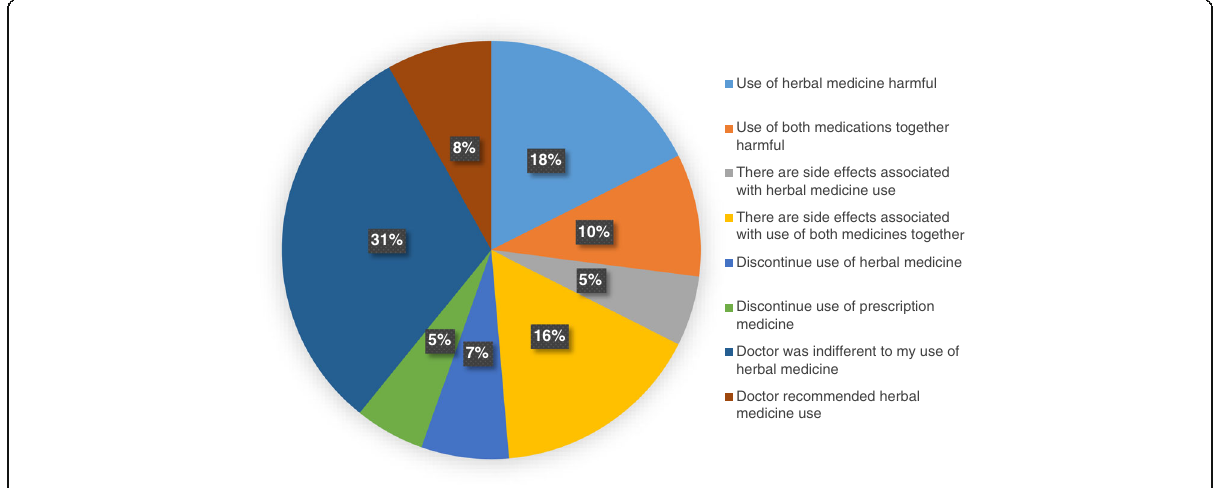
Fig. 4 Doctor ’ s advice regarding herbal medication use during pregnancy